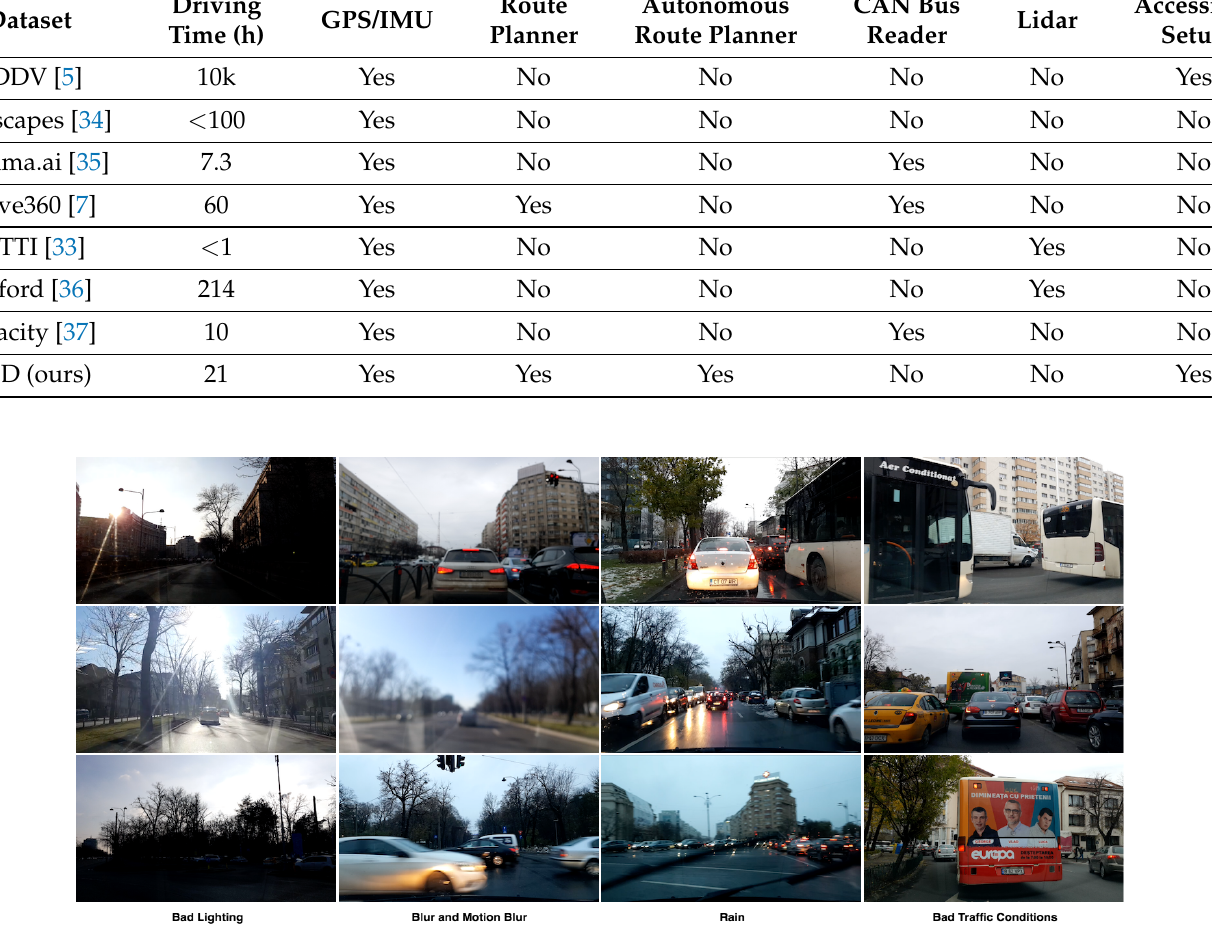
Figure 3. Samples from the dataset taken in challenging conditions such as bad lighting, blur, rain, and heavy